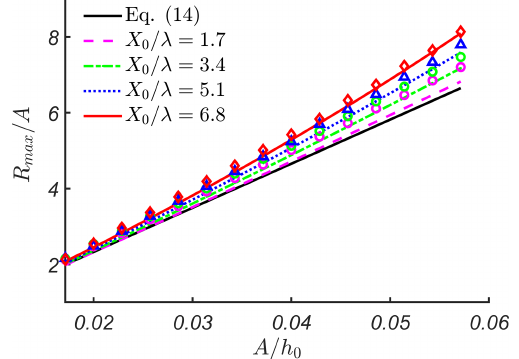
Figure 6. Maximum run-up height, R max /A , as a function of kh 0 for different distances to the slope, X 0 /λ . Analytical solution de- scribed in Sect. 2 is shown by lines, and numerical solution de- scribed in Sect. 3 is shown by symbols (diamonds, triangles, squares and circles) with matching colours. The thick black line corresponds to Eq. (14) for wave run-up on a beach without constant depth sec- tion ( A/h 0 = 0 .